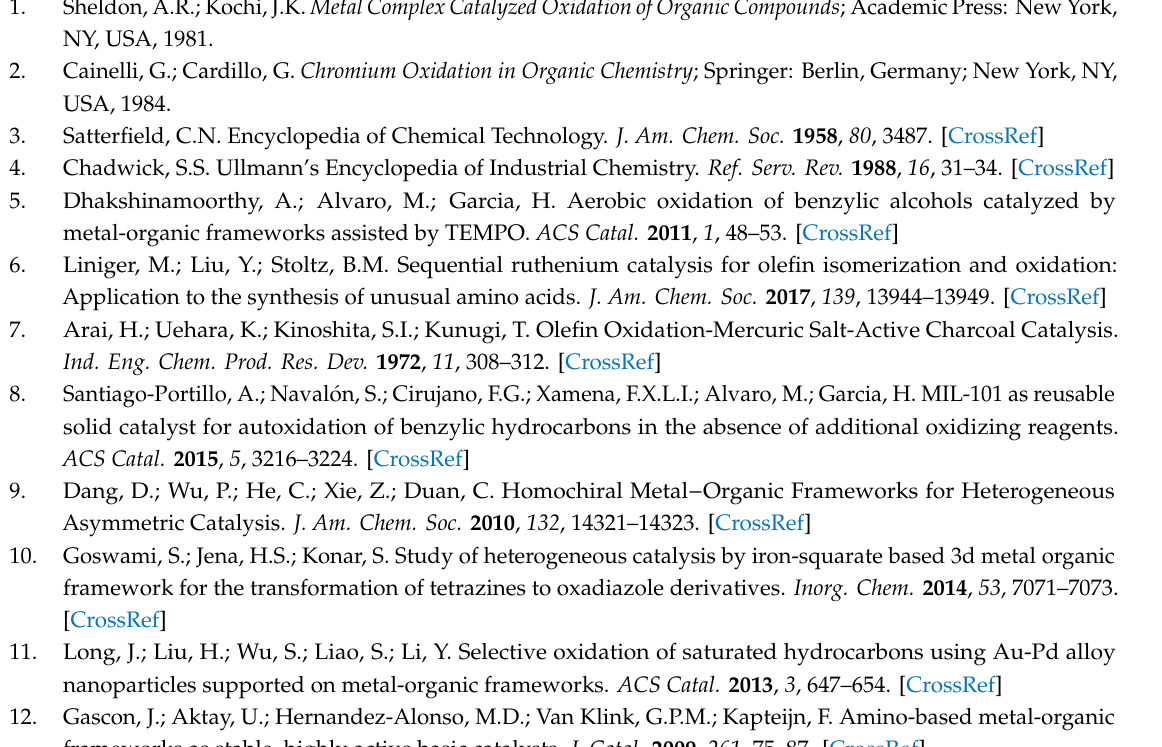
Figure S1: IR spectra of LaCuODA (a) and LaCoODA (b). Table S1: Thermal dependence of aerobic cyclohexene oxidation catalyzed by LaCoODA. Table S2: Conversions for the non-activated and thermally activated catalytic system. Selectivities for the activated catalyst are also